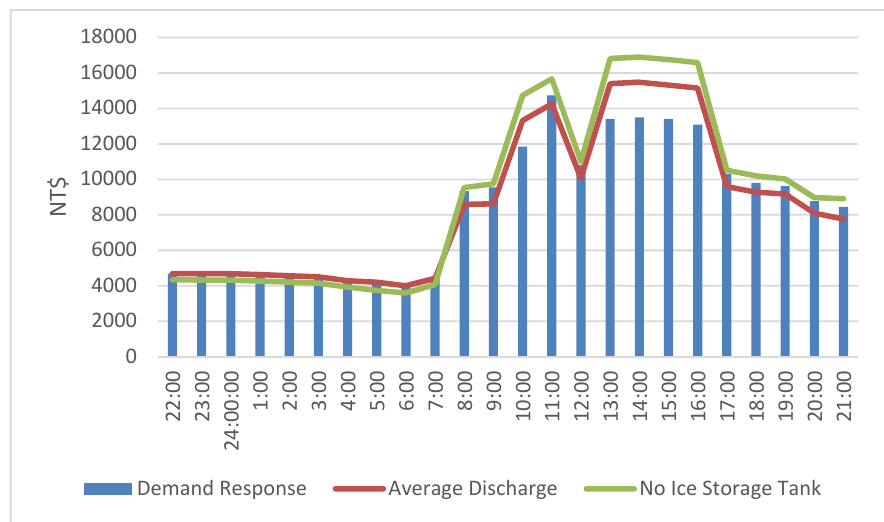
Figure 5. The dynamic electricity price on a summer day (16 July 2013) for IRBSO.